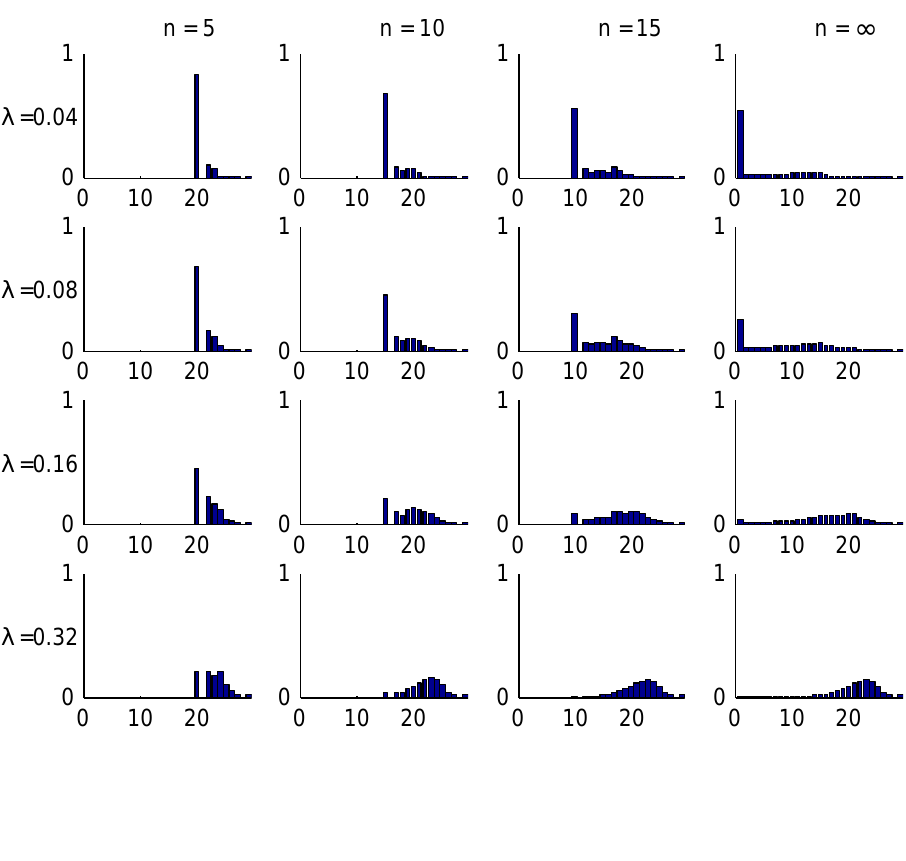
Figure 9. Transient distributions,